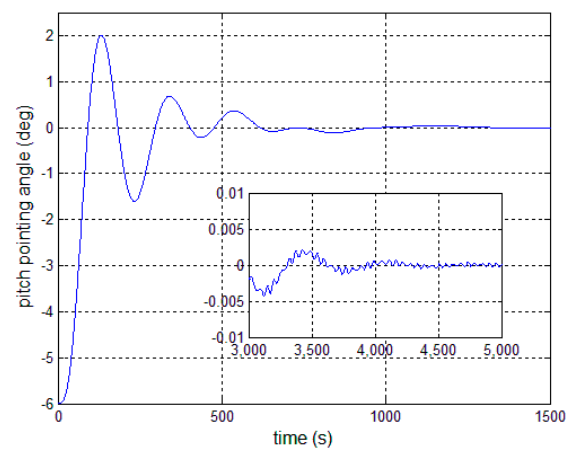
Figure 10. Control torque—controller, Equation (23).